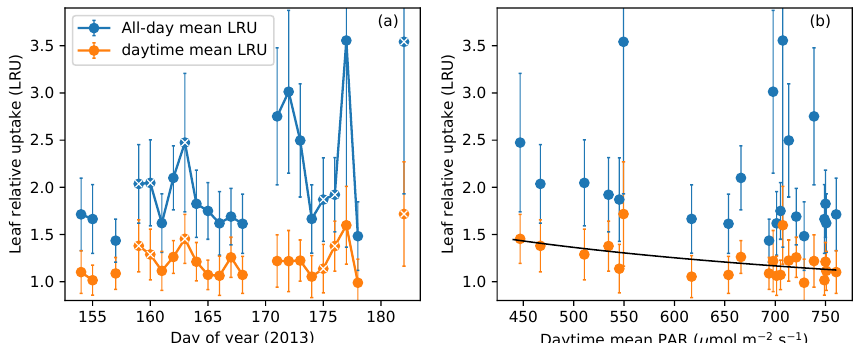
Figure 7. (a) All-day mean (blue) and daytime mean (orange) leaf relative uptake (LRU) ratios during the campaign. Data points from overcast days (daytime mean PAR < 550µmolm − 2 s − 1 ) are labeled with additional white cross signs. (b) All-day mean and daytime mean LRU values vs. daytime mean PAR. Daytime mean LRU vs. PAR follows a response curve (black): LRU = 24.0689 PAR − 0 . 4620 . Error bars in both panels show ranges of ± 1 standard